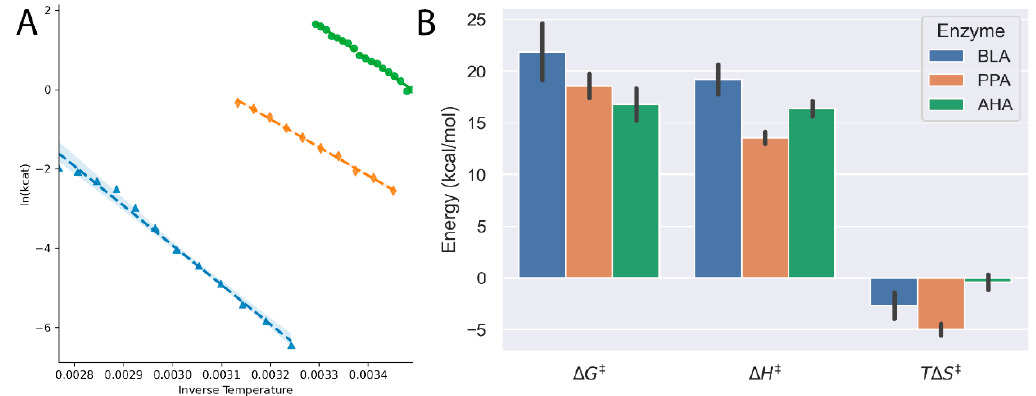
Figure 3. ( A ) Arrhenius plots for Bacillus licheniformis amylase (BLA, blue triangles), pig porcine amylase (PPA, orange diamonds) and Pseudoalteromonas haloplanktis amylase (AHA, green circles) demonstrate the linear temperature dependence on amylase activity. ( B ) The thermodynamic parameters of the activation barrier show clearly that the cold-adapted AHA has a lower energy barrier to overcome for the reaction to proceed.